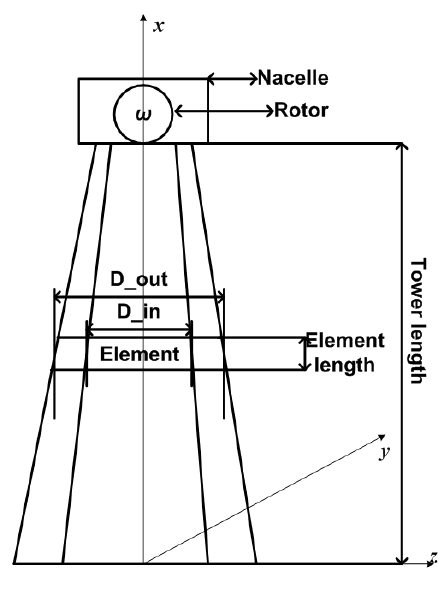
Figure 1 . Model of wind